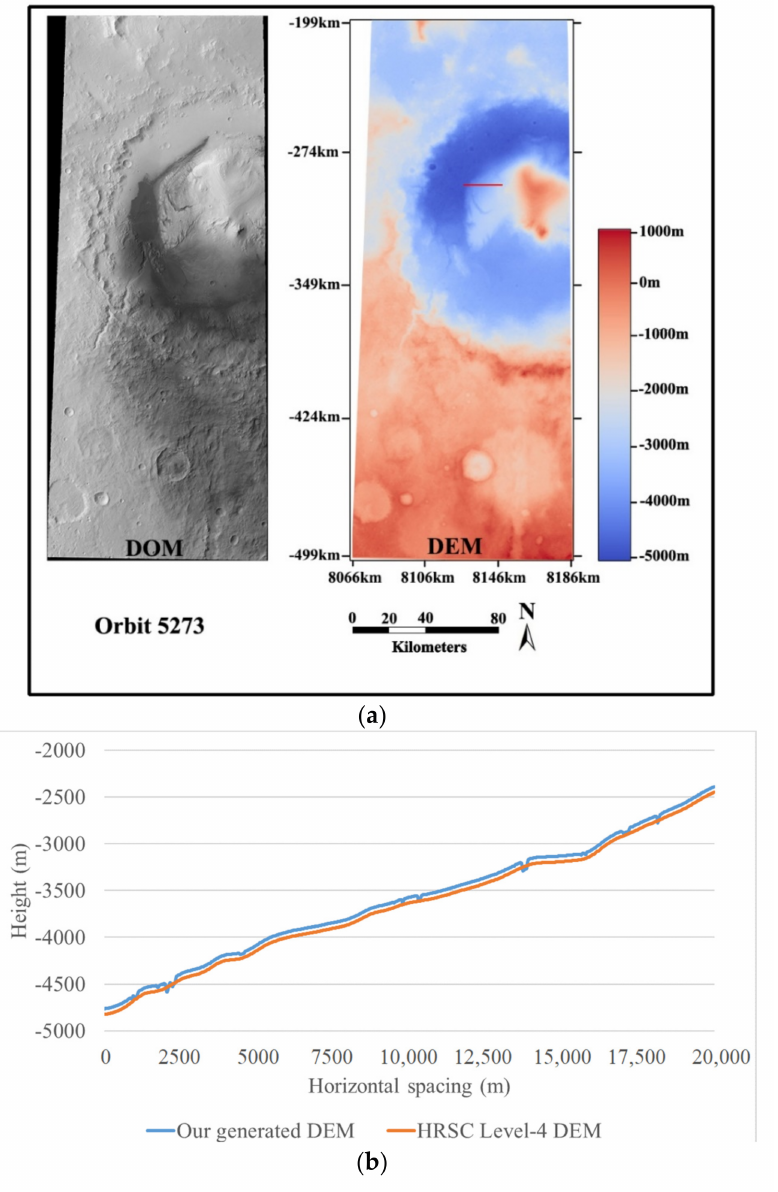
Figure 17. DEM results and terrain profile comparison for orbit 5273: ( a ) DOM and DEM results; and ( b ) terrain profile comparison between the generated DEM and the HRSC Level-4